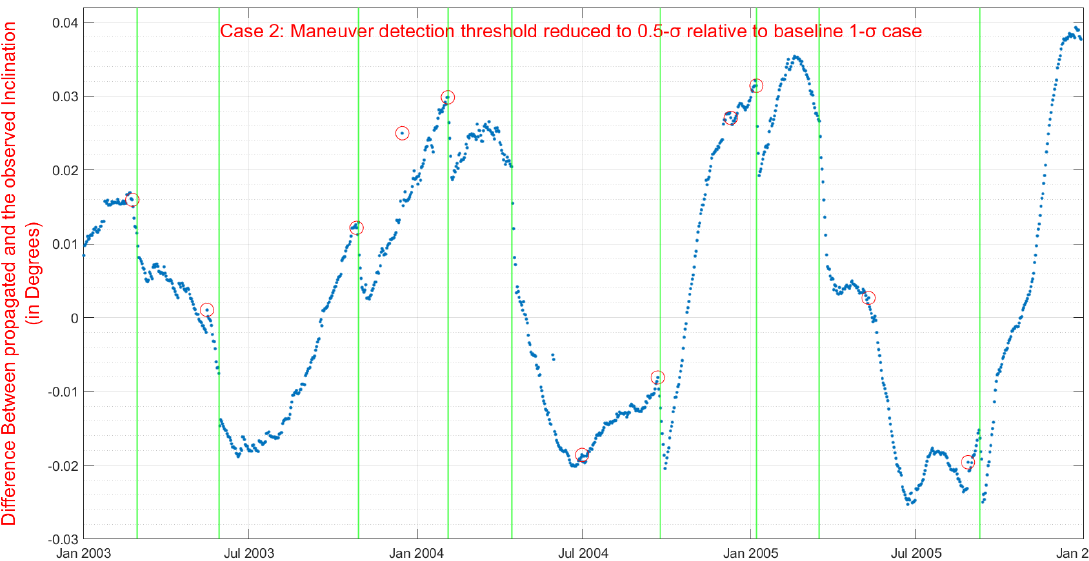
Figure 5. Case 2: Maneuver detection threshold reduced to 0.5-sigma relative to baseline 1-sigma case. Vertical green lines represent the maneuvers and the red circles represent potential maneuvers detected by this